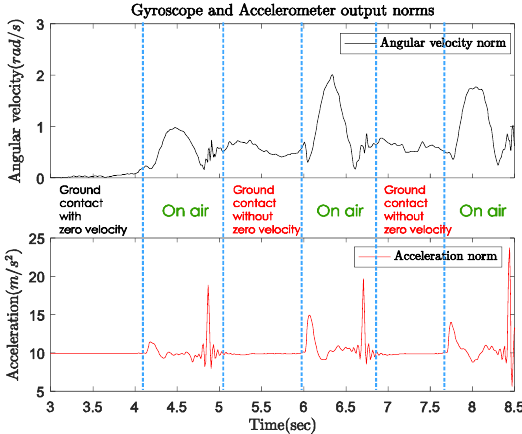
Figure 8. Gyroscope and accelerometer output norms with standard cane.